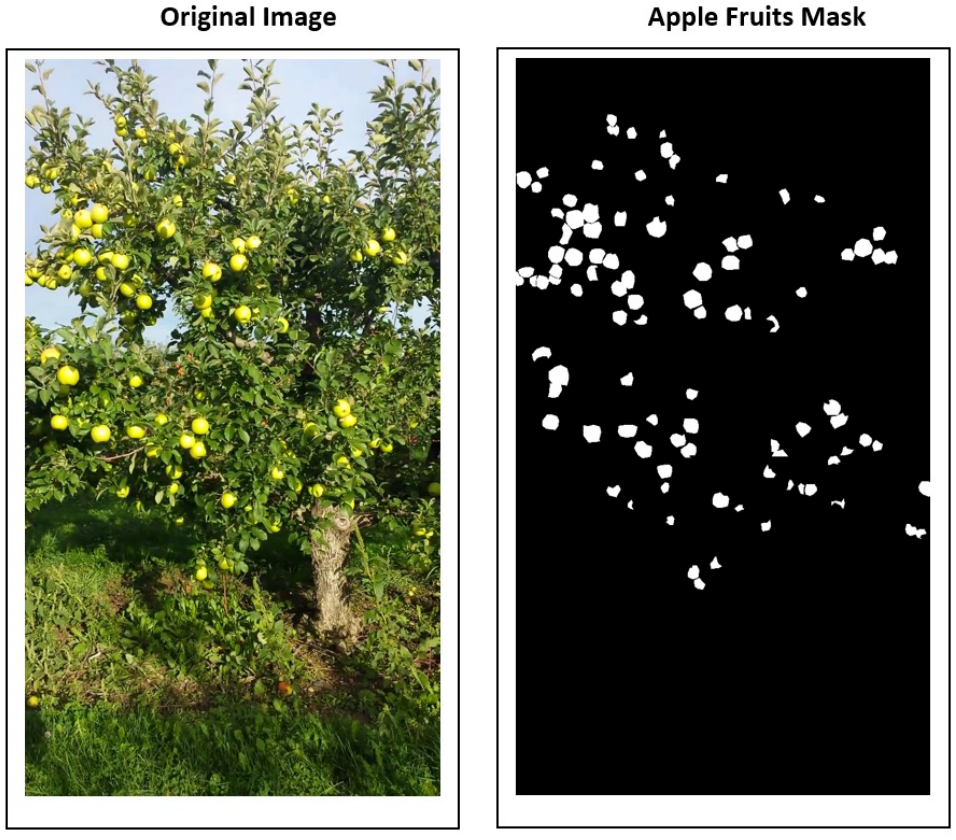
Figure 3. A sample of captured apple trees image and its corresponding ground truth mask of apple